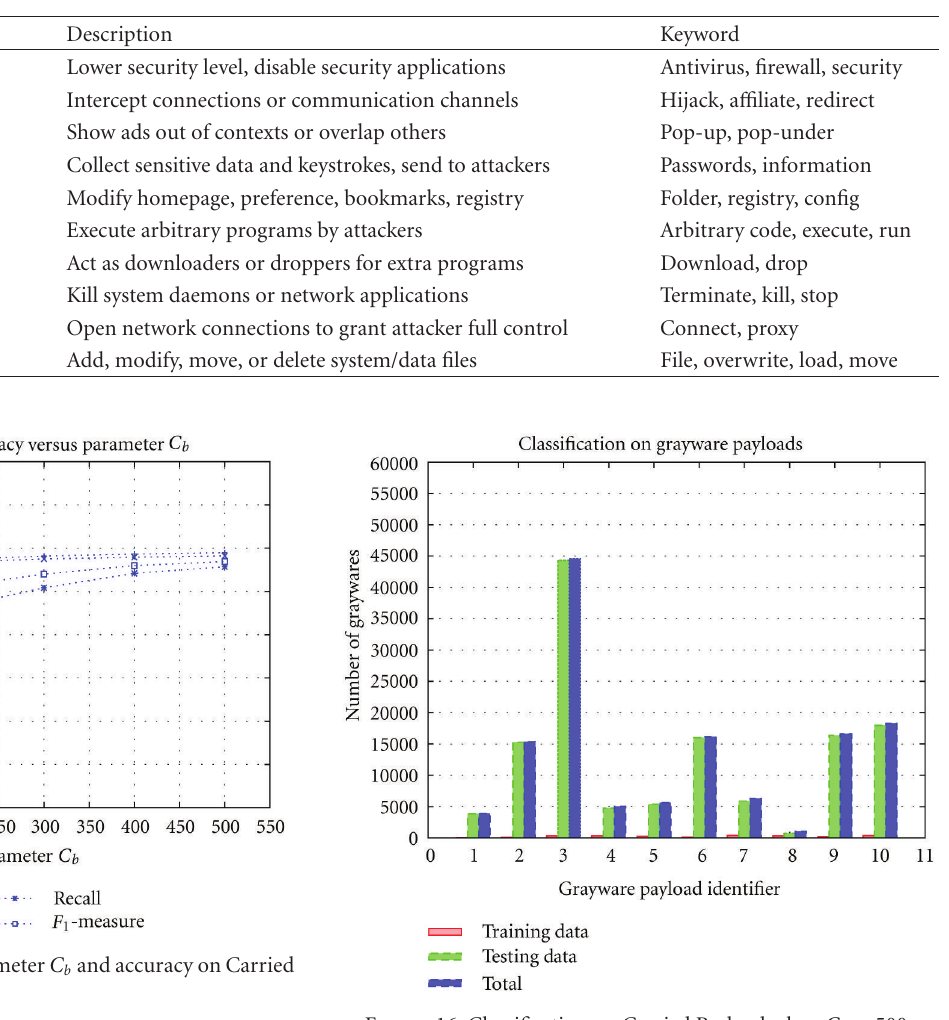
Figure 16: Classification on Carried Payload when C b =